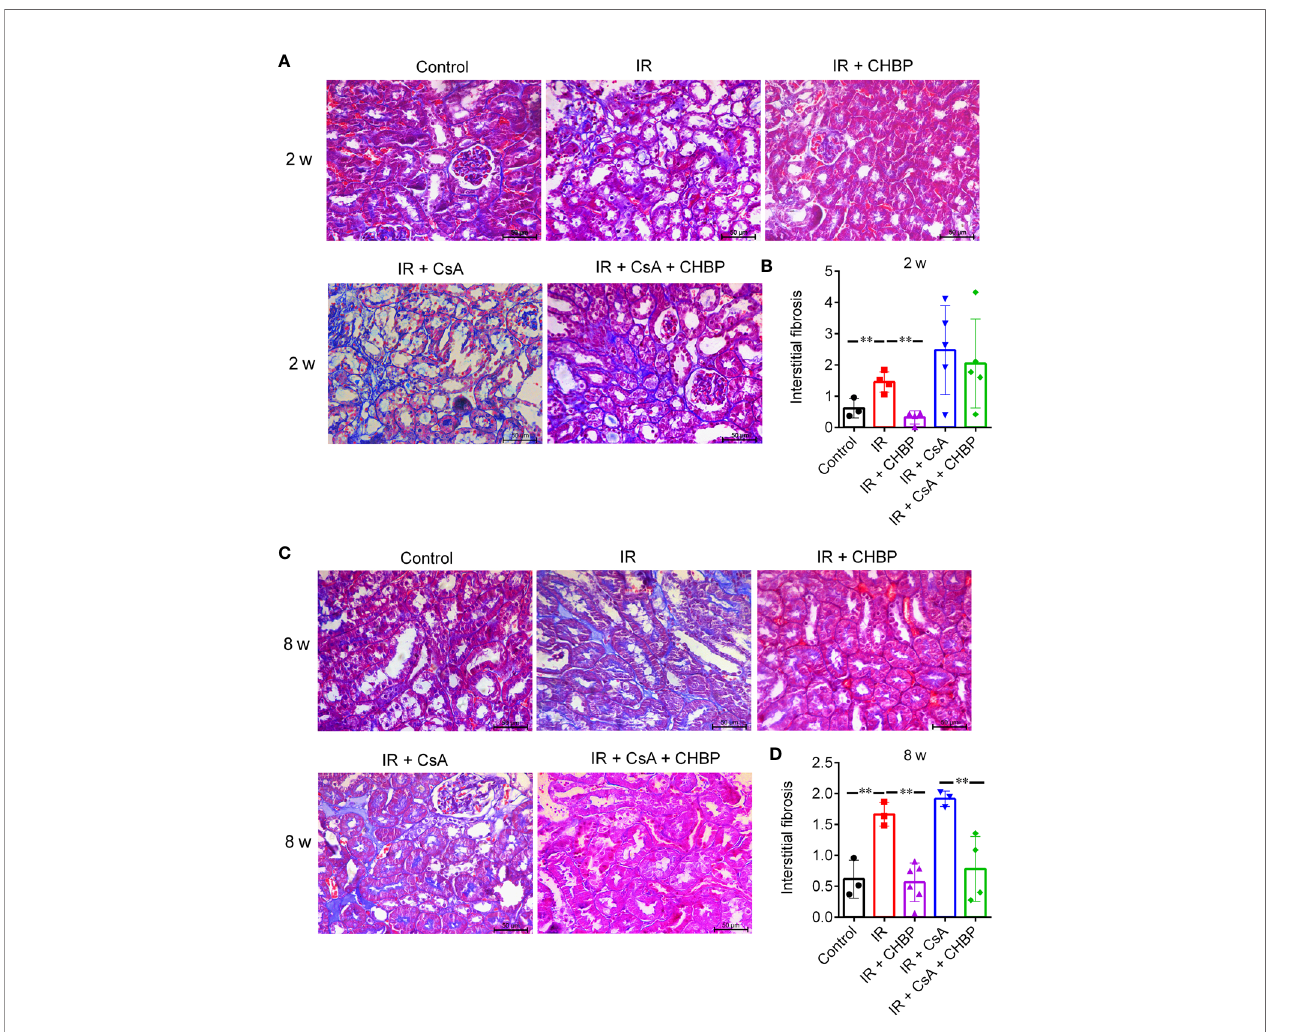
FIGURE 3 | The score of interstitial fi brosis in Masson ’ s trichrome stained sections. (A, C) Masson ’ s trichrome staining revealed the interstitial fi brosis. (B, D) Interstitial fi brosis was increased by IR compared with the control, but improved by CHBP at both time points. (D) The score of fi brosis was signi fi cantly decreased by CHBP in the CsA treated group at 8 weeks. Data were expressed as the mean ± SD of each group (n ≥ 3). ** P ≤